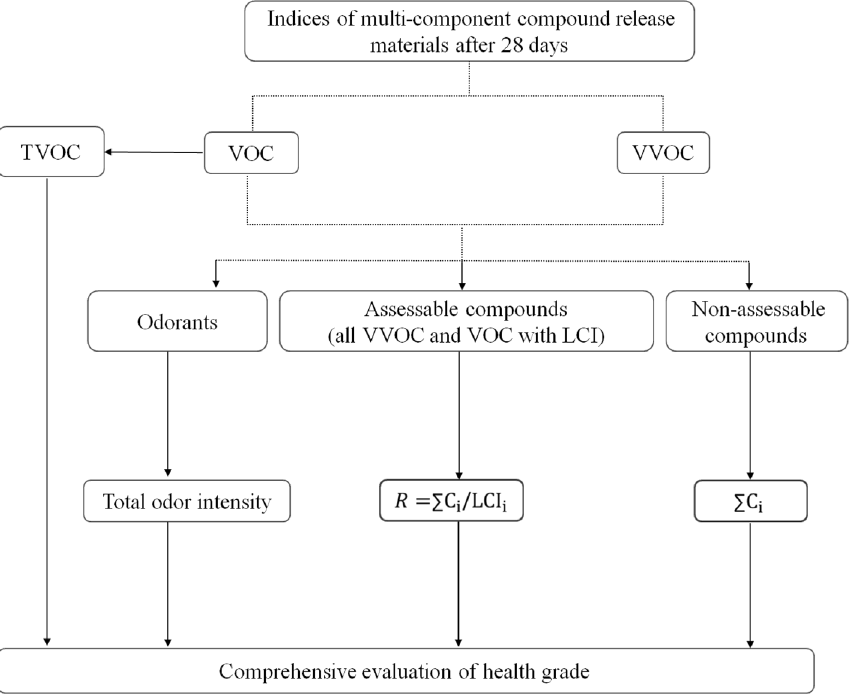
Figure 1. A comprehensive evaluation of the health level of multi-component